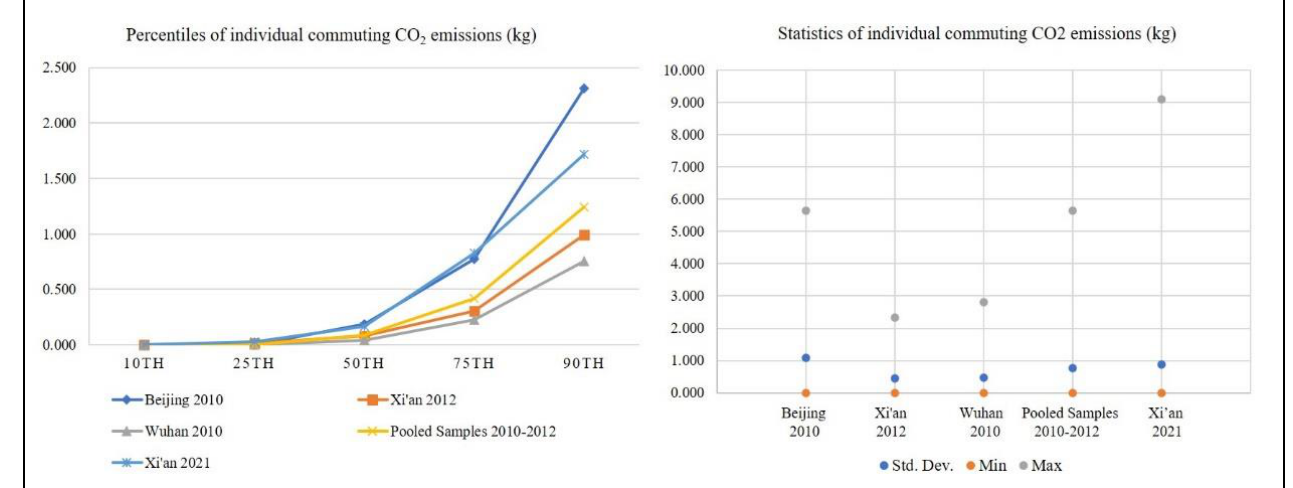
Figure 1. Percentiles and statistics of individual commuting CO 2 emissions in the three case cities in 2010 – 2012 and in Xi’an in 2021 .